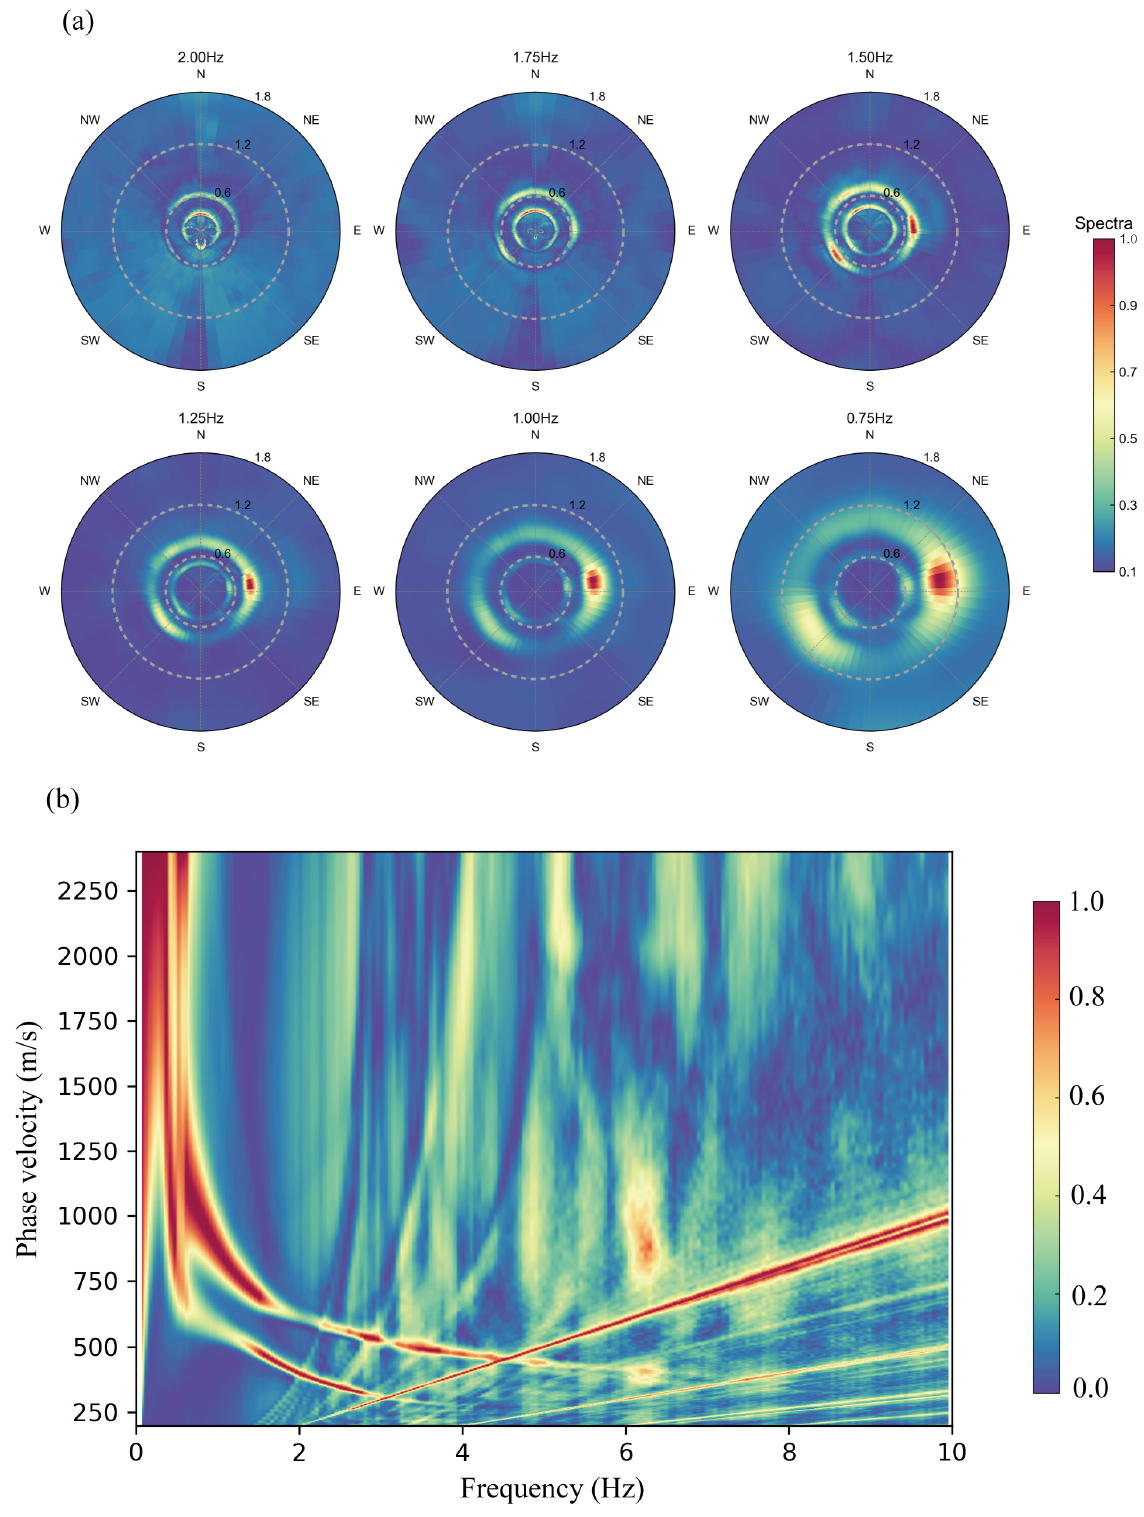
Figure 3. Beam power diagram. ( a ) As a phase velocity and azimuth angle function, the azimuth angle is expressed as different orientations (N, E, S, W), and the gray dotted line in the subgraph represents the phase velocity line (unit: km/s). The results in each subgraph are normalized to their maximum values. ( b ) Multi-mode dispersion image calculated by CCBF. The dispersion pattern is formed by superimposing the average beam power generated from different azimuth.